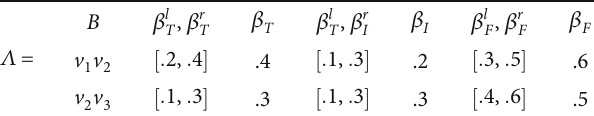
Table 3: A neutrosophic cubic membership for